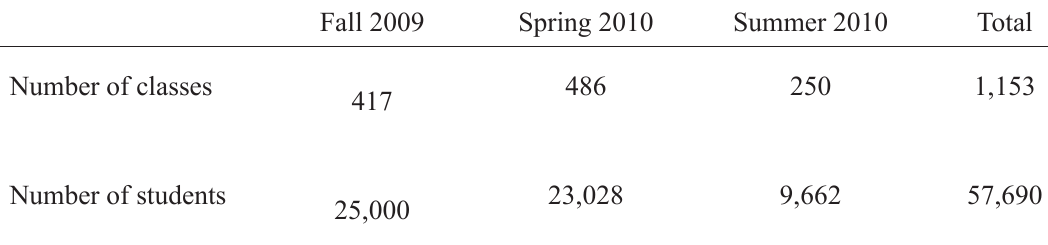
Number of Classes and Students using FWK Materials by